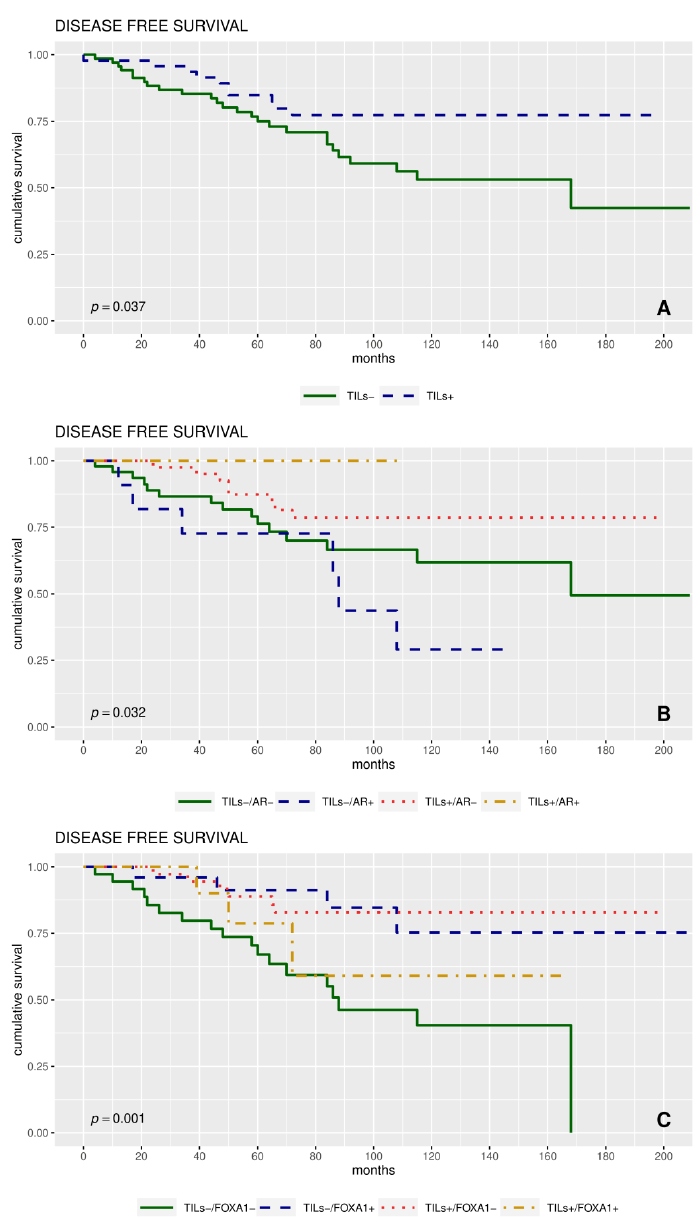
Figure 4. Survival analyses. ( A ) Disease-free-survival (DFS) curves for patients with tumor-infiltrating lymphocytes positive (TILs + ; reverse Kaplan–Meier method median follow up: 108, 95% confidence interval (CI) (85–140); events: 10 / 47) versus TILs- (median follow up: 104, 95% CI (86–142); events: 26 / 70) presence ( p = 0.037). ( B ) DFS curves for patients with simultaneously TILs– / androgen receptor (AR)– (median follow up: 104, 95% CI (77–151); events: 15 / 47), TILs– / AR + (median follow up: 142, 95% CI (61-not available (NA); events: 6 / 11), TILs +/ AR − (median follow up: 118, 95% CI (89–143), events: 8 / 40), TILs +/ AR + (median follow up: 84, 95% CI (77–NA); events: 0 / 5) expression: The four Kaplan–Meier curves resulted significantly different ( p = 0.032). ( C ) DFS curves for patients with simultaneously TILs − / forkhead box A1 (FOXA1)– (median follow up: 110, 95% CI (68–164); events: 18 / 36), TILs − / FOXA1 + (median follow up: 92, 95% CI (62–147); events: 4 / 26), TILs +/ FOXA1 − (median follow up: 117, 95% CI (89–143); events: 6 / 36) and TILs +/ FOXA1 + (median follow up: 110, 95% CI (60–NA); events: 3 / 10) expression: The four Kaplan–Meier curves resulted significantly different ( p =